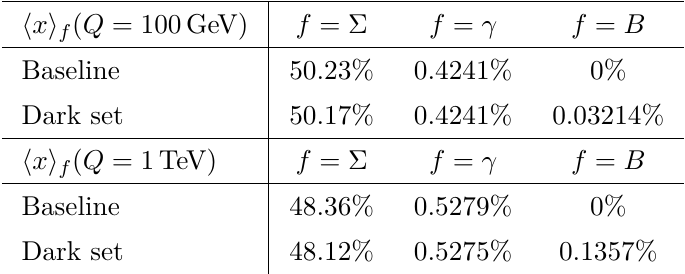
Table 1 . A comparison between the momentum fraction percentage carried by the singlet Σ , the photon γ , and the dark photon B at Q = 100 GeV and Q = 1 TeV, for the baseline SM set and the dark PDF set, obtained with the photon coupling and mass given in eq. (2.6). The momentum fraction is computed on the central replica in each